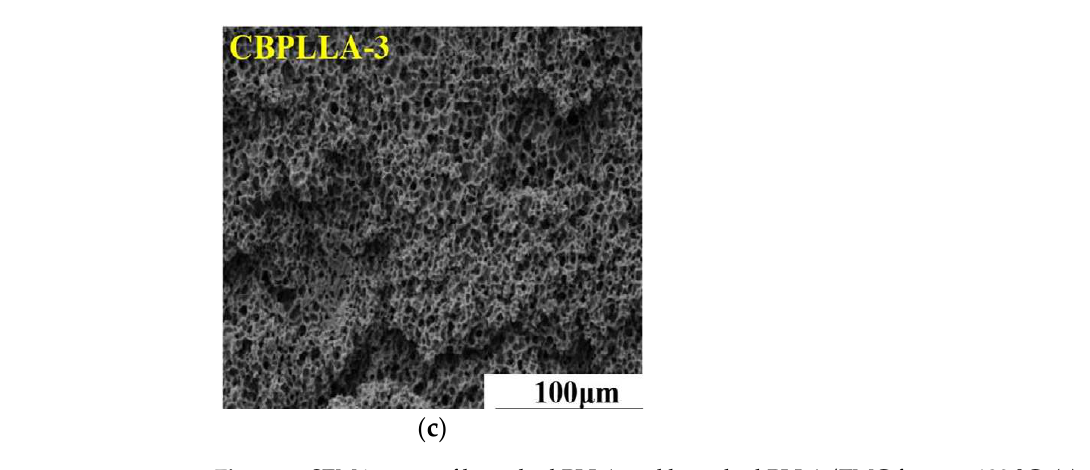
Figure 6. SEM images of branched PLLA and branched PLLA/TMC foam at 130 °C: ( a ) pure PLLA; ( b ) 1 wt% TMC-300; ( c ) 3 wt% TMC-300 (reproduced with permission from Reference [91], Copyright 2022 Elsevier).